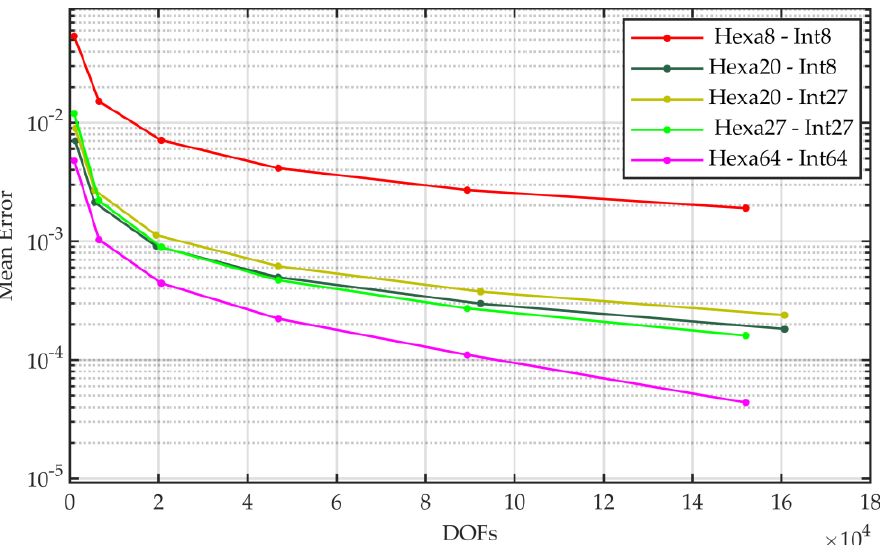
Figure 3. Convergence analysis of three FE formulations (quadratic, serendipity 20 − nodes, and serendipity 20 − nodes with reduced integration) as a function of the number of DOFs in comparison with linear and cubic full elements.